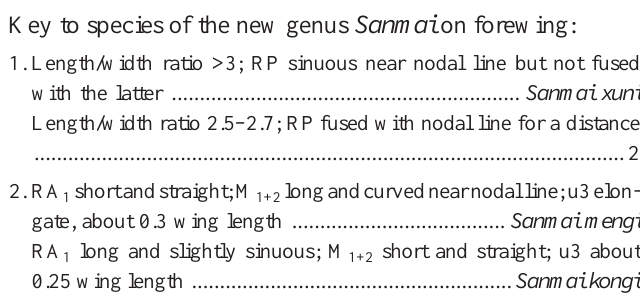
Etymology : In reference to the family name of Confucius (Kung Fu- Tsy), the founder of Confucianism. Type material : Holotype, STMN48-1800a, b (part and counterpart), well-preserved adult female in lateral aspect with overlapped wings at the top of the body. Paratype, STMN48-1801, well-preserved adult male in lateral aspect with overlapped wings at the top of the body. Type locality : Daohugou Village, Ningcheng County, Inner Mongolia, China. Type horizon : Upper Middle–lower Upper Jurassic Daohugou